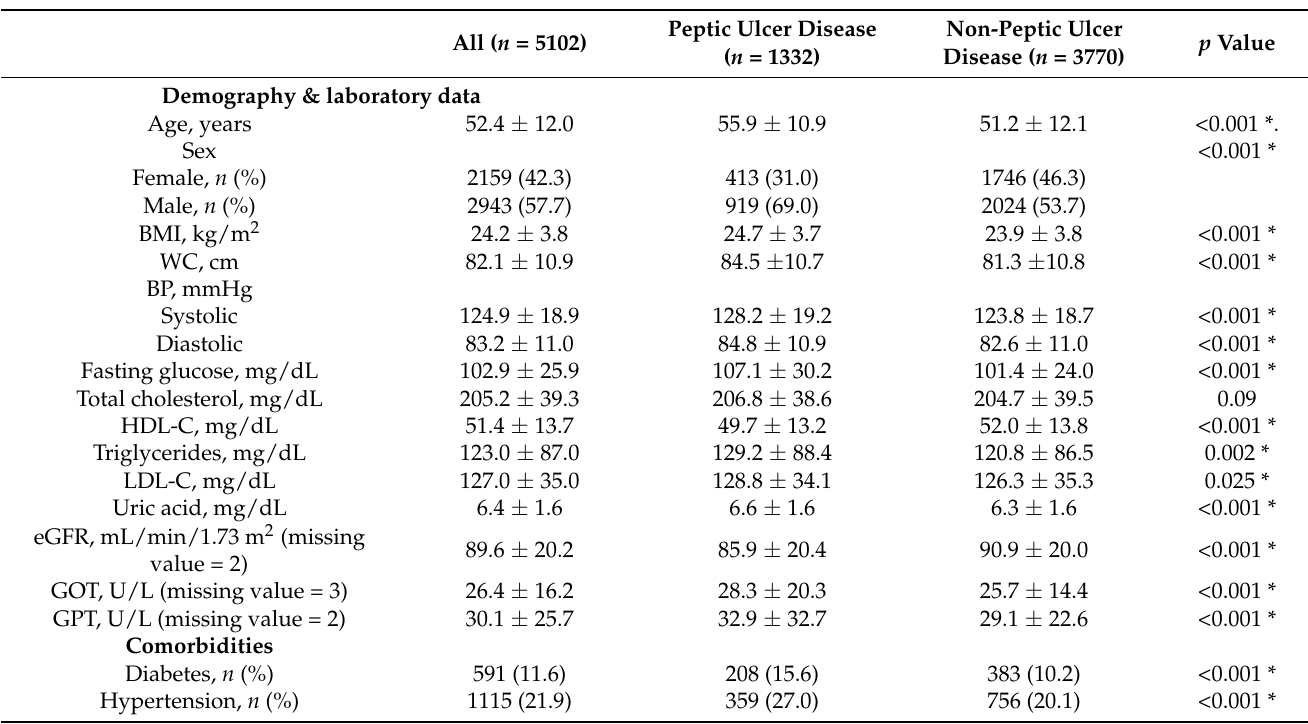
Table 1. Differences in baseline characteristics between peptic ulcer disease and non-peptic ulcer disease